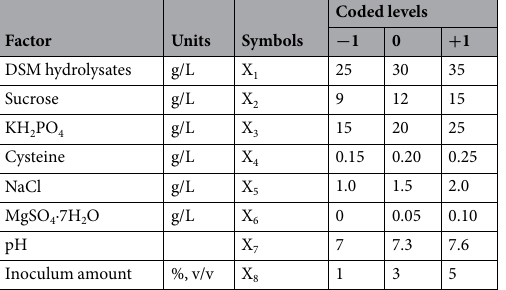
Table 1. Variables and their levels chosen for the experimental design.